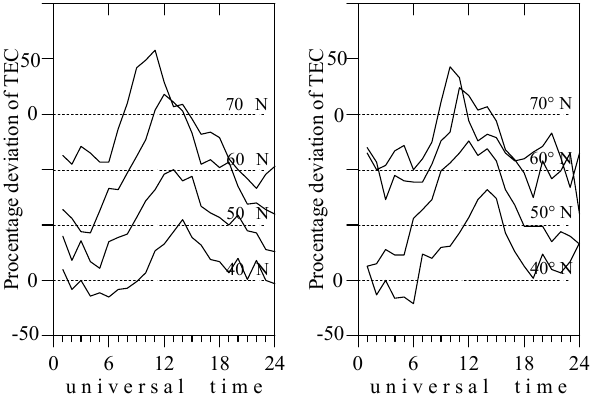
Fig. 9. Diurnal profiles of relative TEC changes on 15 September (left panel) and 16 September (right) at different latitudes (40 ◦ , 50 ◦ , 60 ◦ , 70 ◦ N). Each curve is shifted downwards by